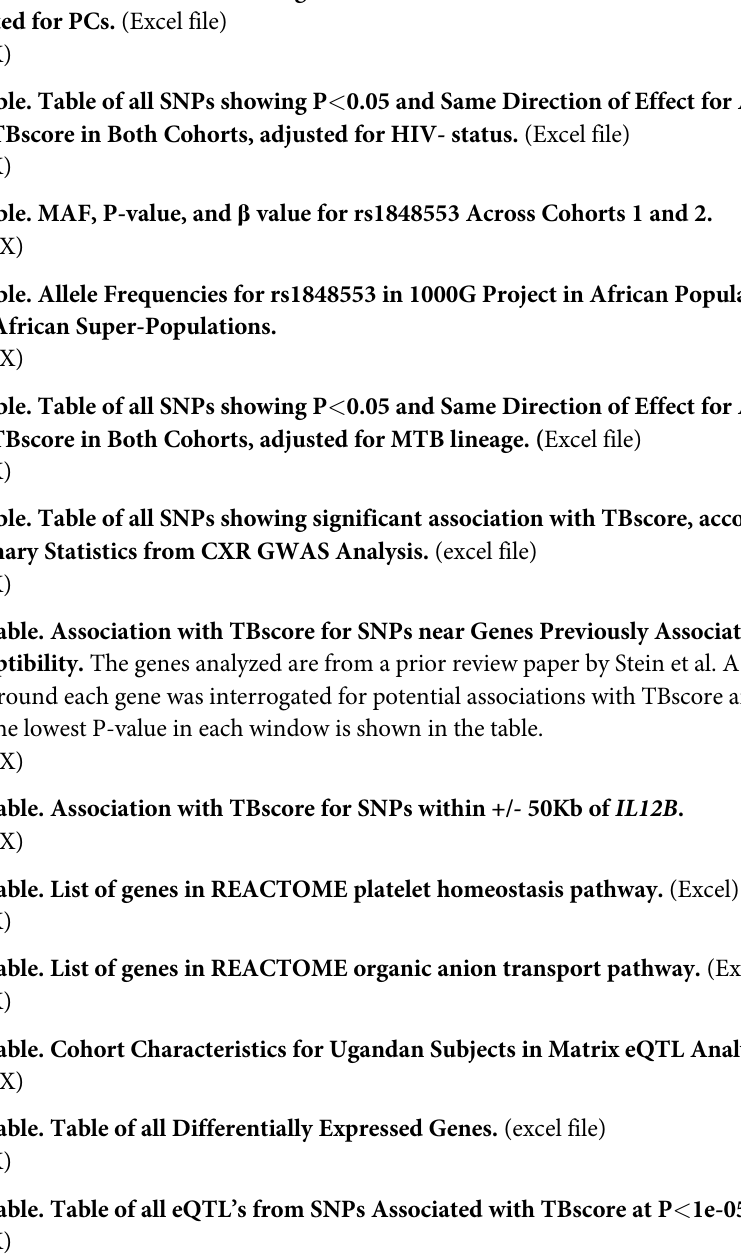
S12 Table. List of genes in REACTOME platelet homeostasis pathway. (Excel) (XLSX) S13 Table. List of genes in REACTOME organic anion transport pathway. (Excel) (XLSX) S14 Table. Cohort Characteristics for Ugandan Subjects in Matrix eQTL Analysis. (DOCX) S15 Table. Table of all Differentially Expressed Genes. (excel file) (XLSX) S16 Table. Table of all eQTL’s from SNPs Associated with TBscore at P < 1e-05. ( excel file)